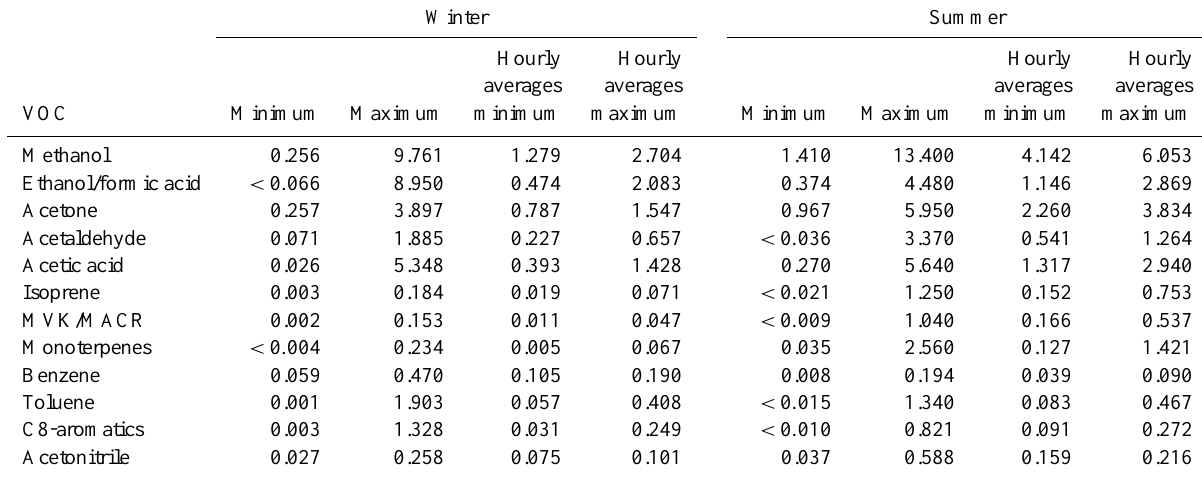
Table 2. Minimum and maximum VOC mixing ratios (ppbv) recorded at MSY station during the winter and summer campaigns. Winter Summer Hourly Hourly Hourly Hourly averages averages averages averages VOC Minimum Maximum minimum maximum Minimum Maximum minimum